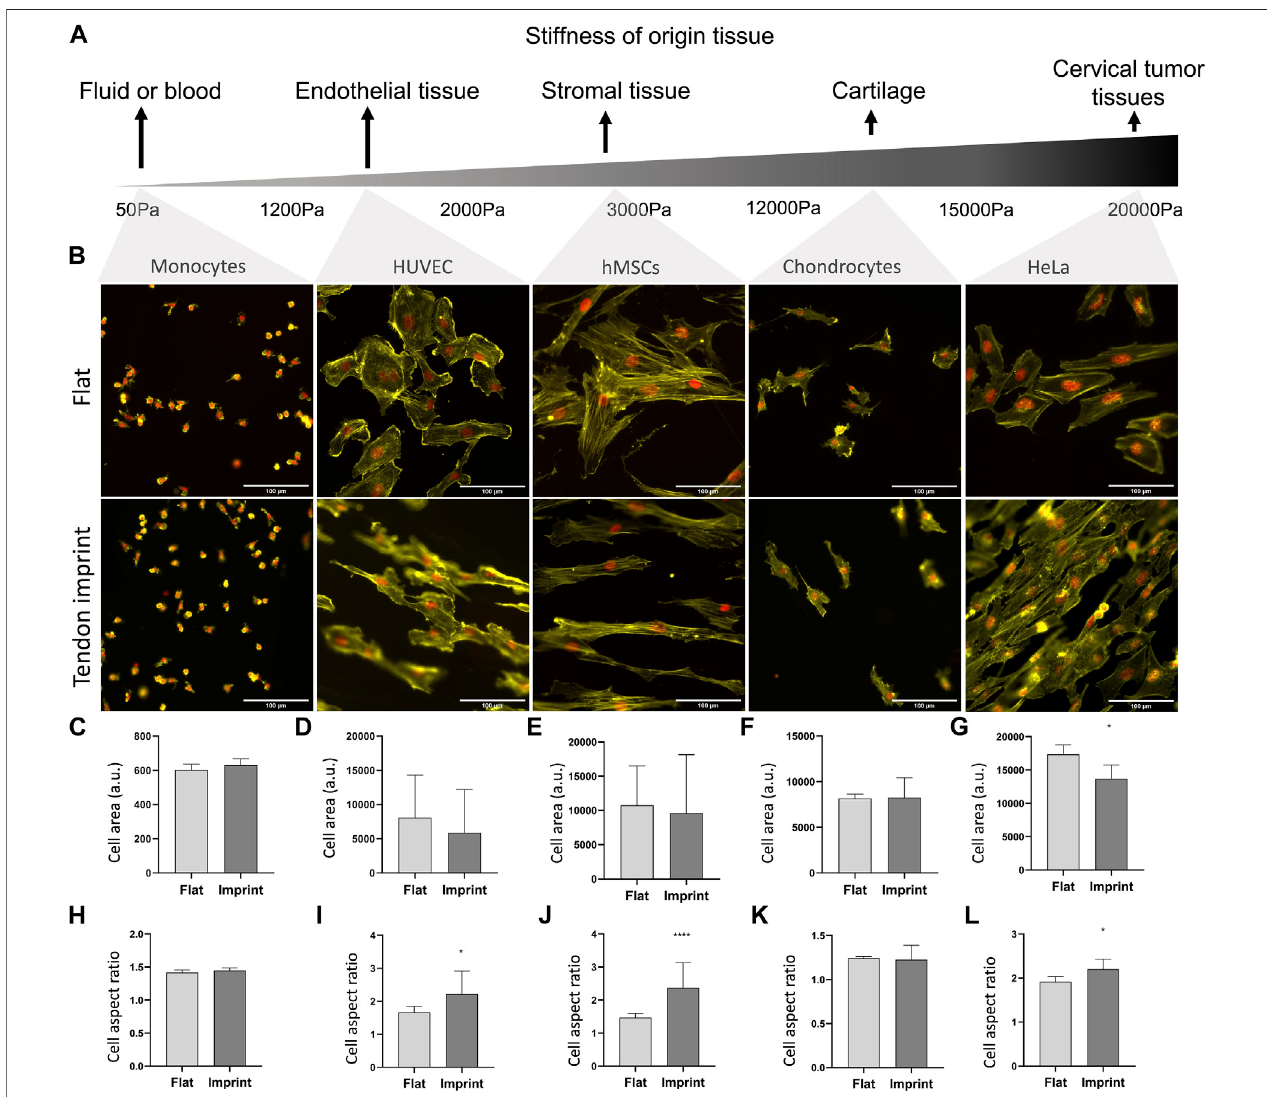
FIGURE 9 | Different cells on tendon imprint undergo similar changes in the cell area and aspect ratio. (A) Panel illustrating the stiffness of tissues from which the monocytes, HUVEC, hMSCs, chondrocytes, and HeLa cells originate. From left to right, tissue stiffness increases. (B) Phalloidin (yellow) and DAPI (red) staining of monocytes, HUVEC, HMSCs, chondrocytes, and HeLa cells cultured after 24 h of culture on a fl at surface and the tendon imprint. Scale bars represent 100 µM. (C – G) Quanti fi cationofthecellarearemainedinsimilarvaluesinallcellsexceptforHeLacellsonthetendonimprint. (H – L) Quanti fi cationofcellaspectratioshowsthatthe tendon imprint leads to a signi fi cant increase in the cell aspect ratio of the hMSCs, HeLa, and HUVEC cells (Error bars represent 95% con fi dence intervals, * p < 0.05, **** p < 0.001). For all experiments, N = 1.